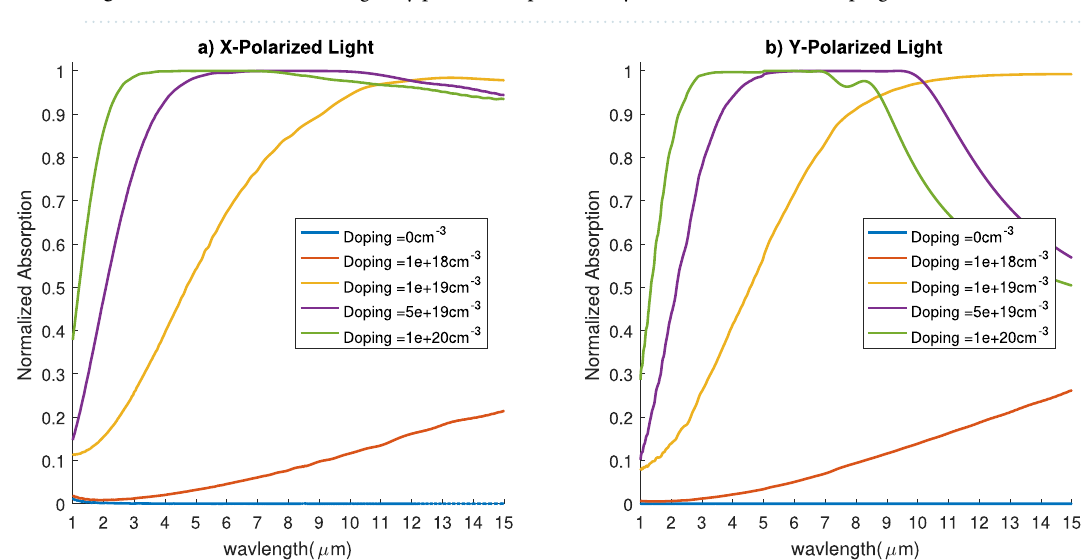
Figure 3. Absorption spectrum for different doping concentrations for x-polarized waves ( a ) and y-polarized waves ( b